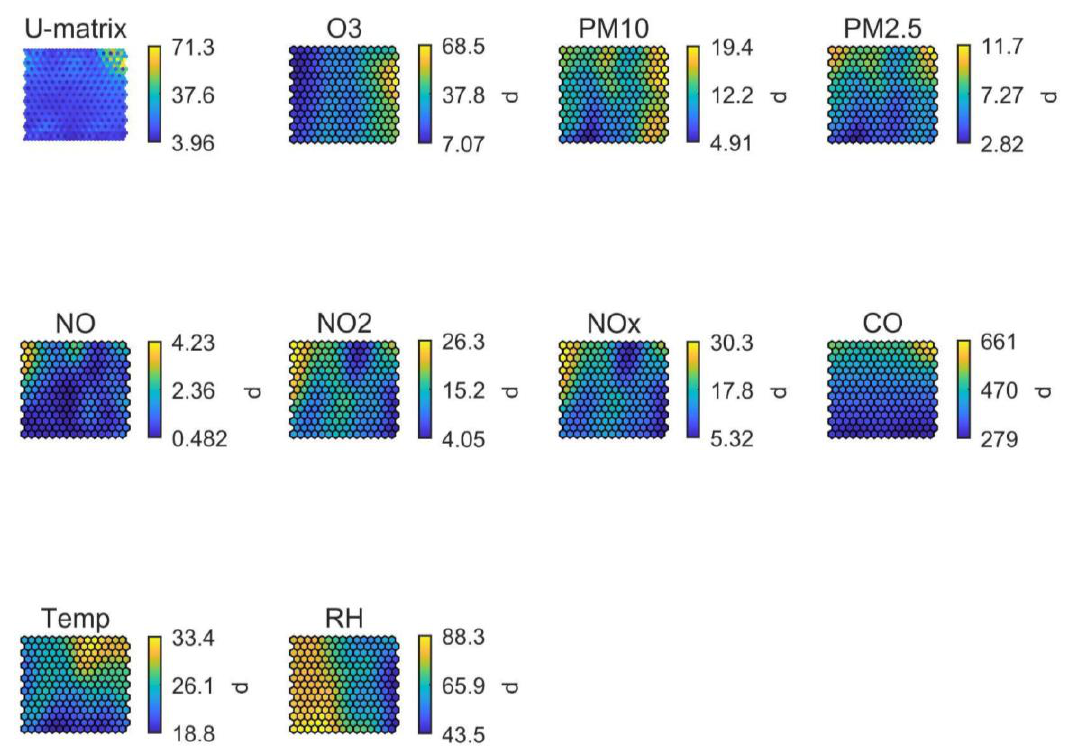
Figure 8. SOM of available data for stadium #5, in Asia. The colour scale is automatically adjusted among graphs and does not reflect the full range of values per parameter.